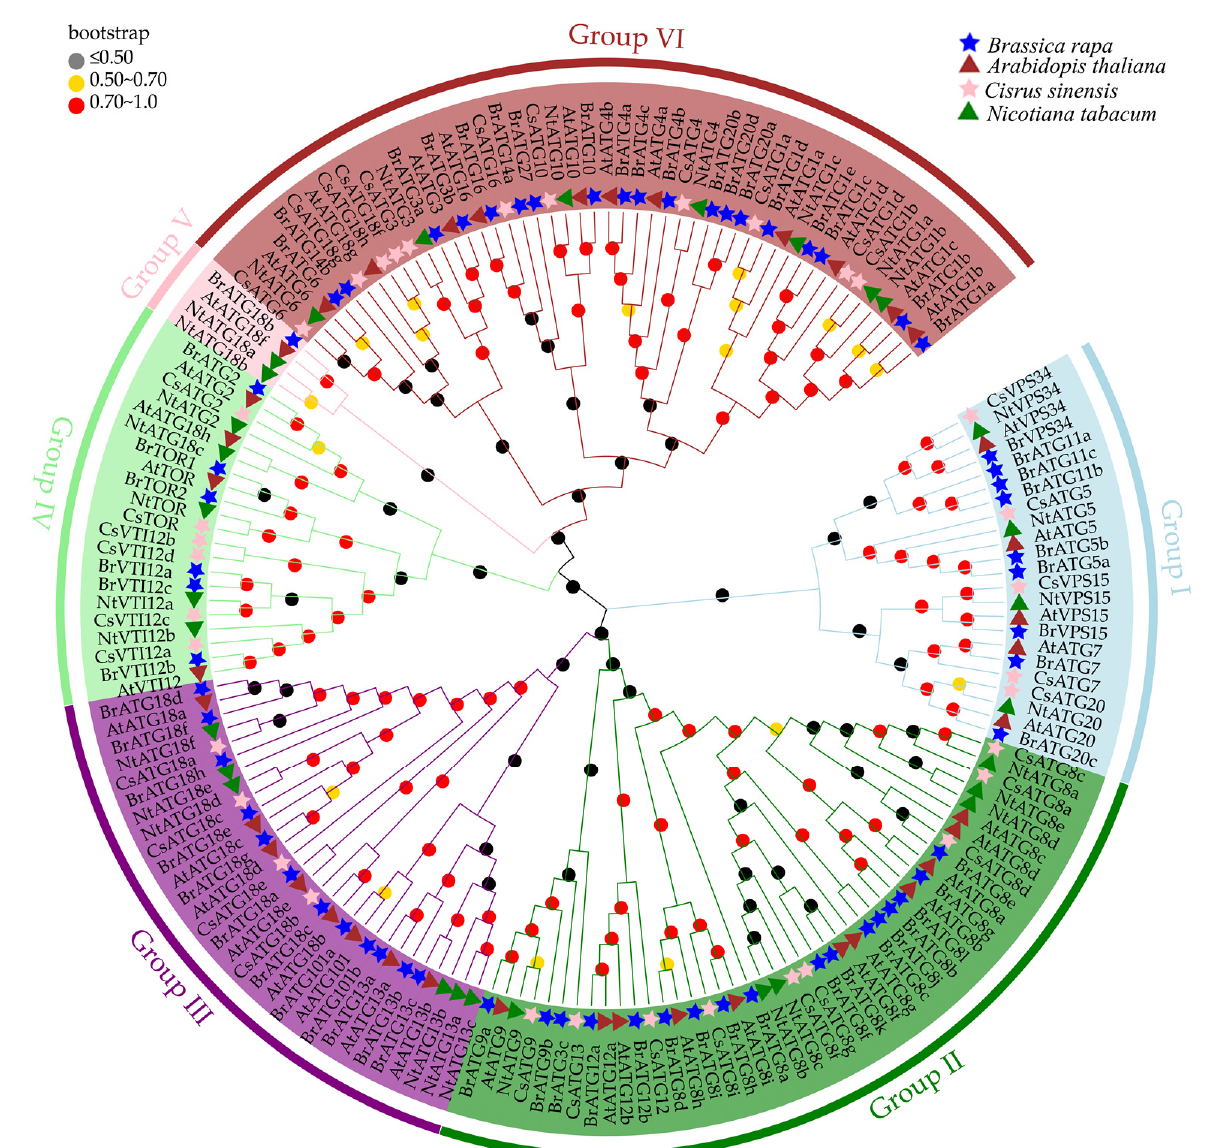
Figure 1 . Phylogenetic relationships of known ATGs in Brassica rapa (Br), Arabidopsis thaliana (At), Nicotiana tabacum (Nt), and Citrus sinensis (Cs). A phylogenetic tree was constructed using MEGA11 software for a total of 169 ATG protein sequences from four species. ATGs of different species are highlighted with blue stars, brown triangles, green triangles, and pink stars corresponding to BrATGs, AtATGs, NtATGs, and CsATGs, respectively.